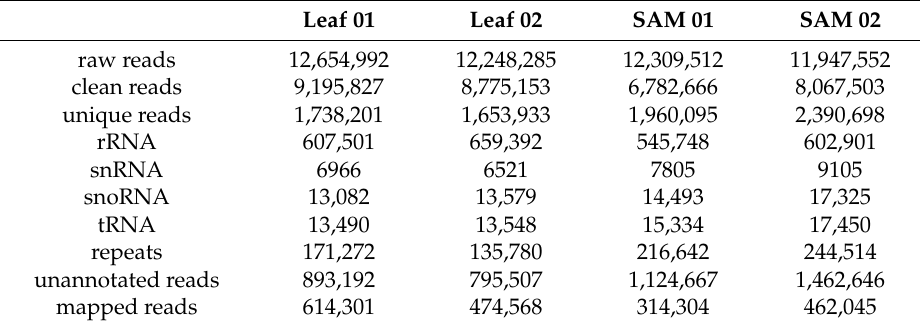
Table 1. Analysis of sRNAs from leaf and SAM libraries.